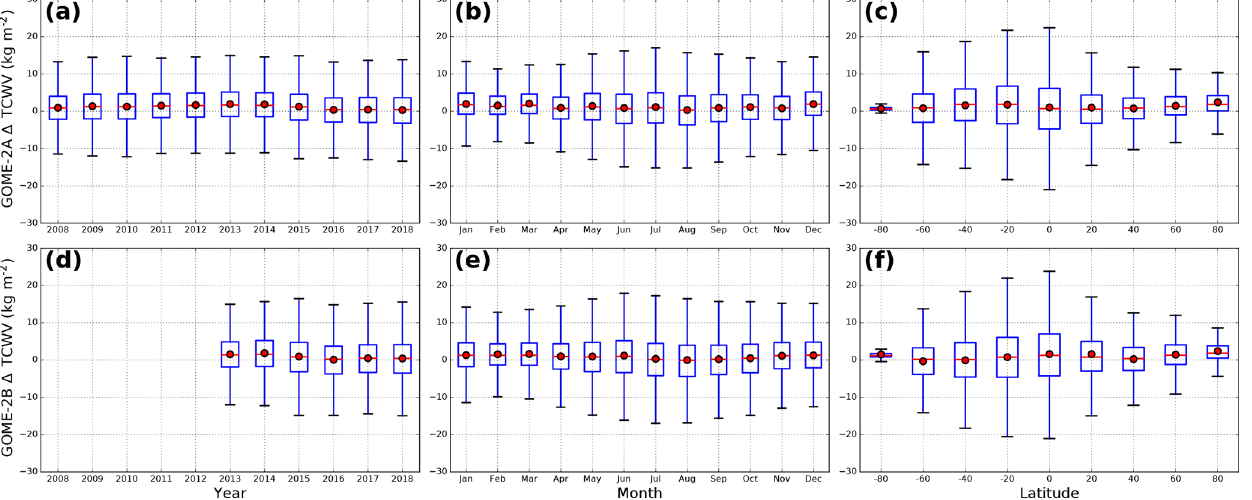
Figure 15. Comparison between radiosonde and GOME-2A observations. Panels (a–c) show GOME-2A data and panels (d–f) show GOME- 2B data. Data are sorted by year in (a) and (d) , month in (b) and (e) , and latitude in (c) and